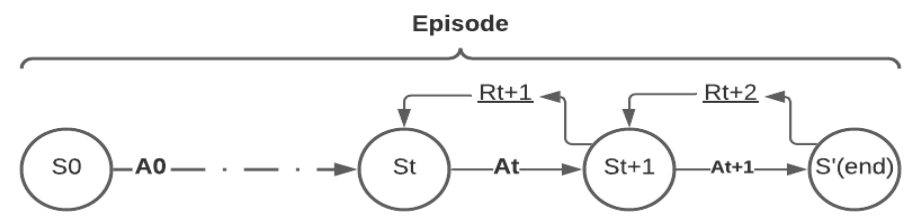
Figure 2. Episode